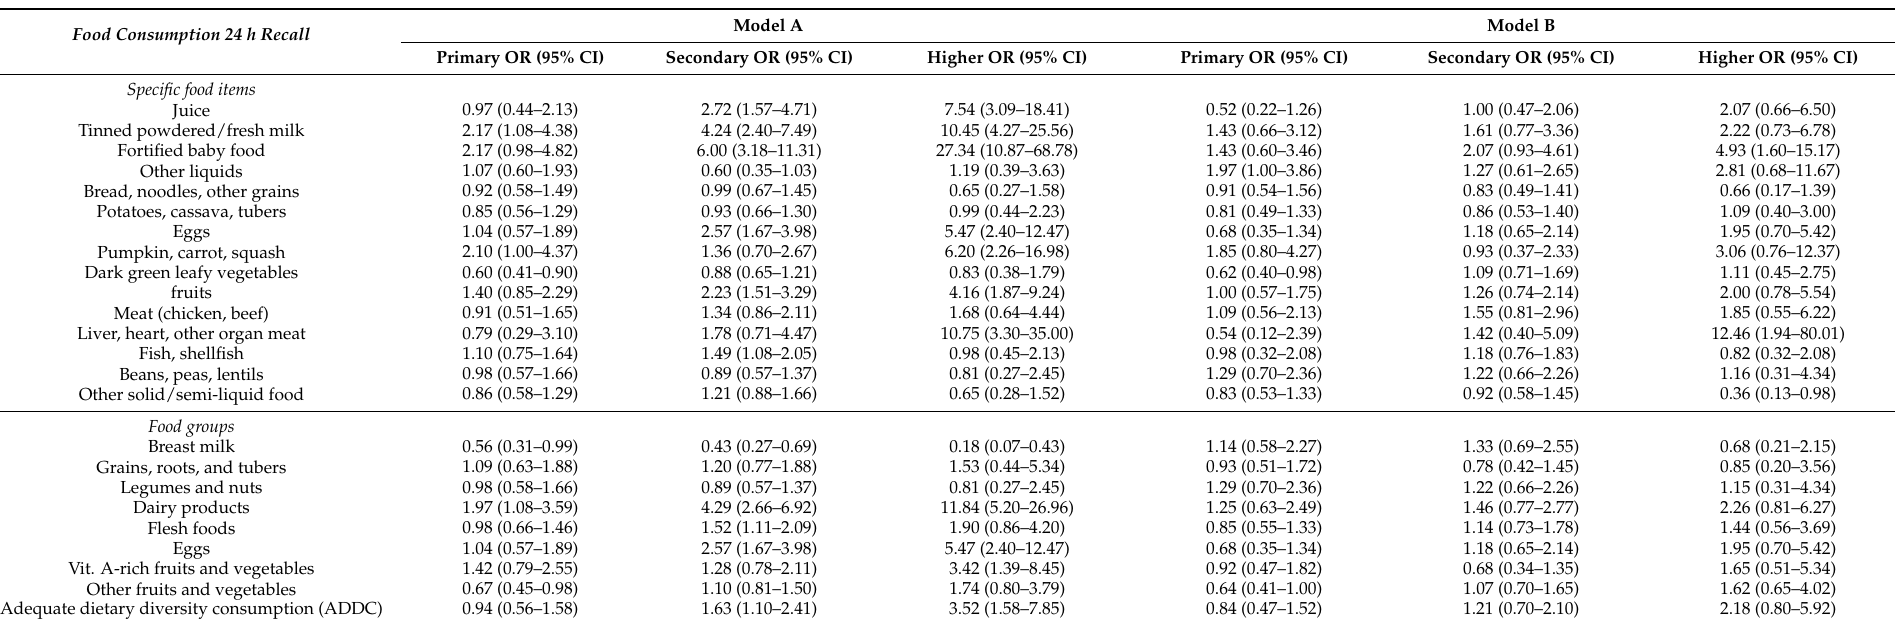
Table 7. The association between mother’s education and consumption of food items, food groups, and adequate dietary diversity of children aged 6–23 months, adjusted odds ratios (ORs) with confidence intervals (CIs),